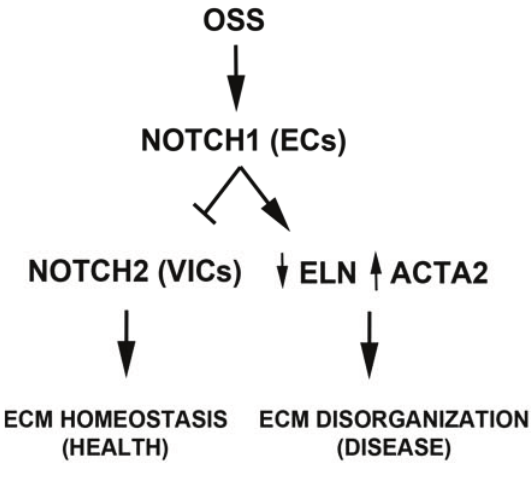
Figure 8. Proposed model of NOTCH signaling dysregulation and OSS. In health, oscillatory shear stress (OSS) acts directly on NOTCH1 signaling in AVECs to promote ECM homeostasis in the interstitium in cooperation with NOTCH2. In disease, NOTCH LOF results in decreased ELN and increased ACTA2 and loss of ECM